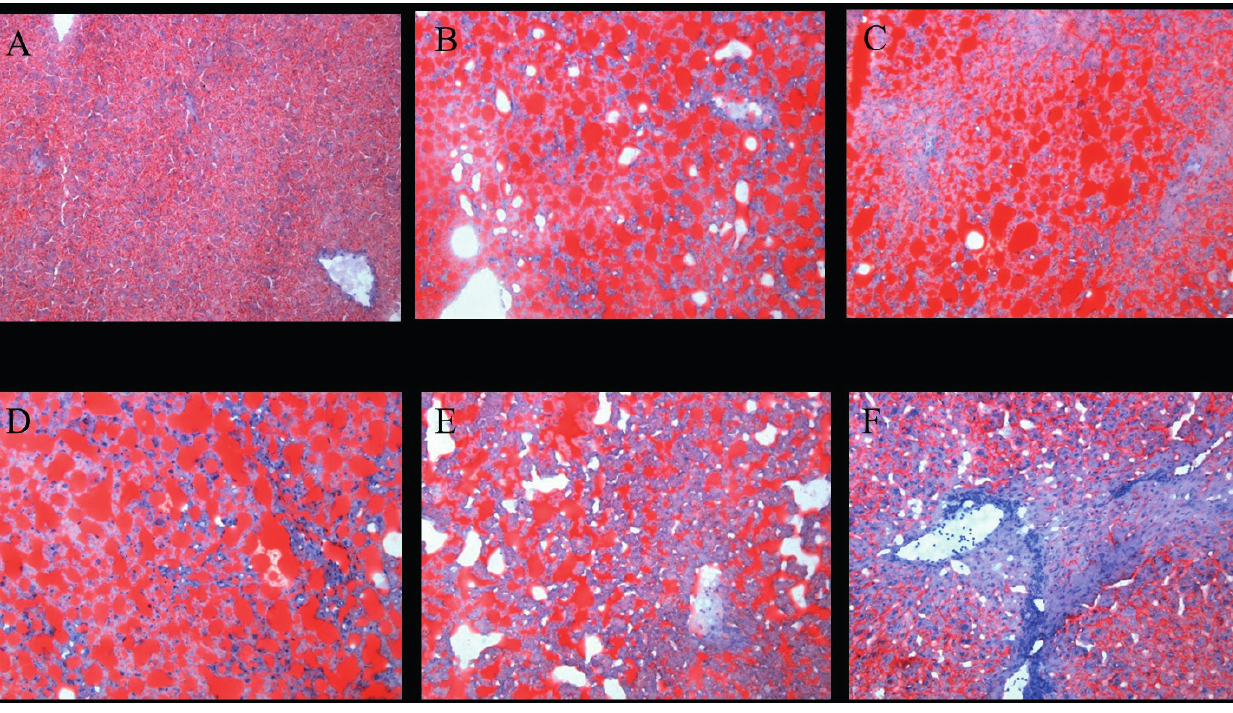
FIGURE 6 - Effects of BCLE on hepatic histopathological changes of KK-A y mice. Hepar sections by oil red O staining at a magnification of ×100. A. blank control group, B. Model control, C. positive control, D. ZS group, E. F1 group, F. F2